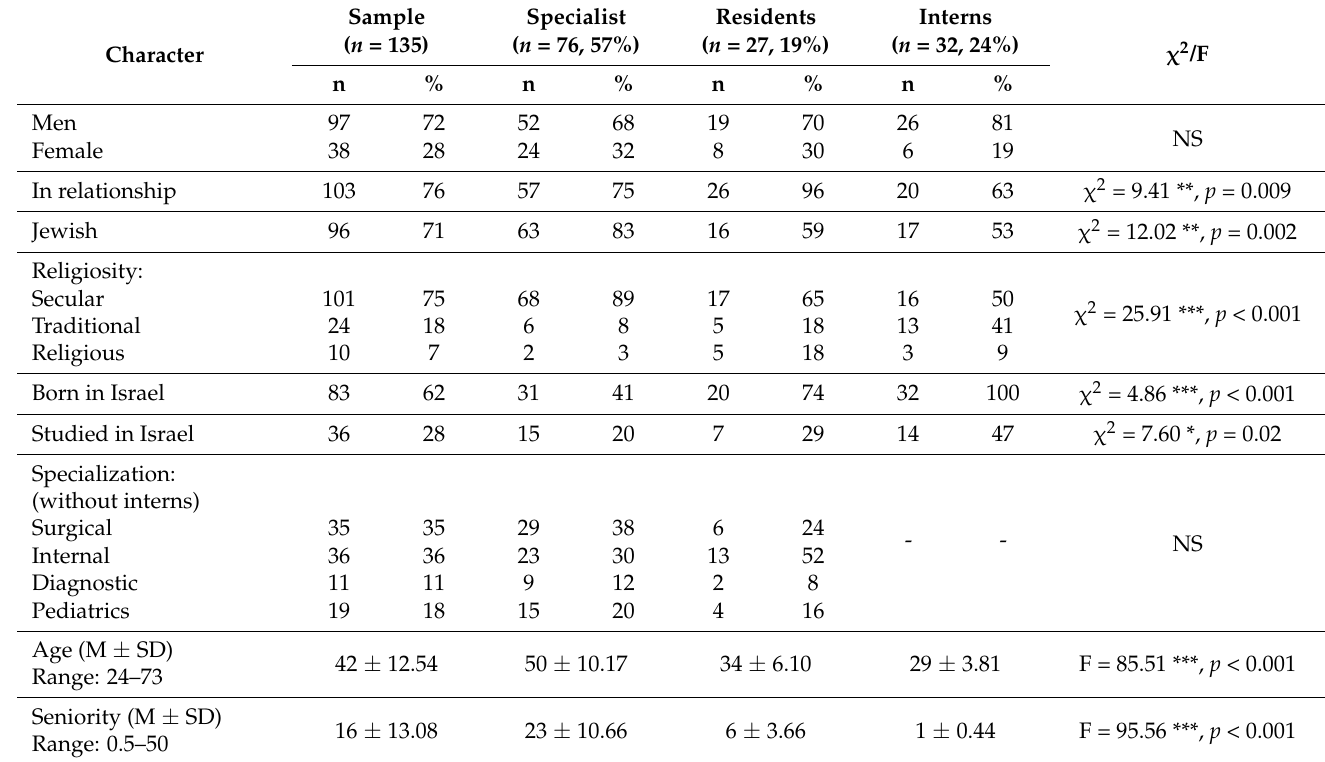
Table 1. Physician Respondents